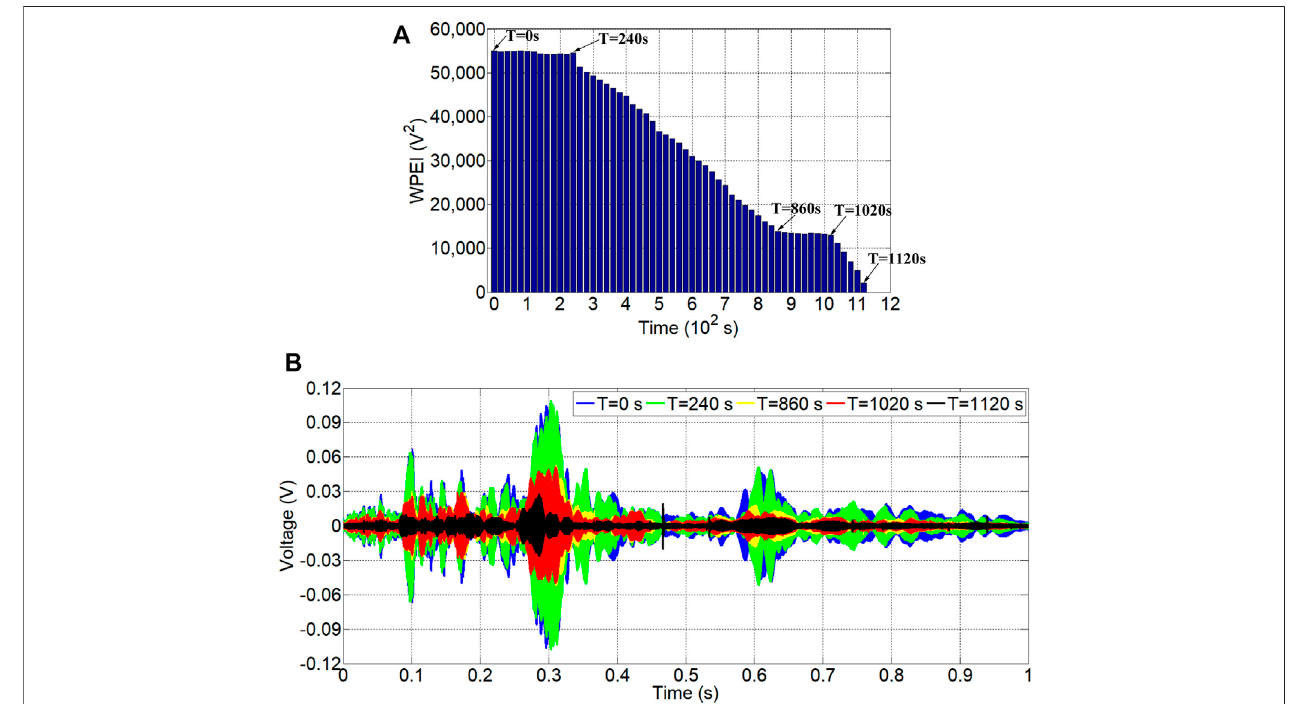
FIGURE 9 | WPEIs and received signal of S2: (A) WPEIs of the received signal; (B) the received stress wave signal.